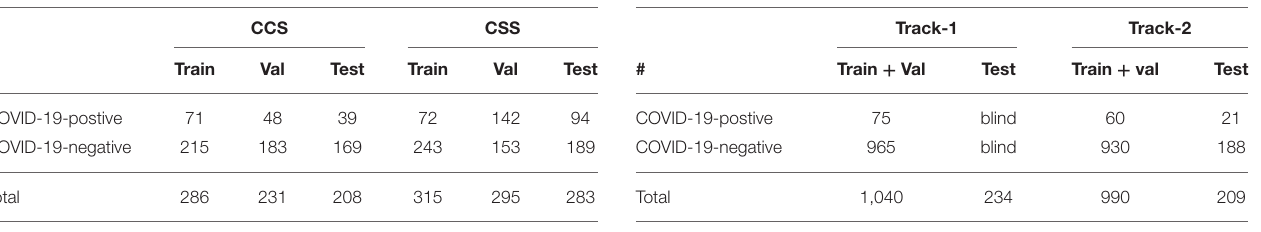
TABLE 1 | ComParE sub-challenge dataset splits.